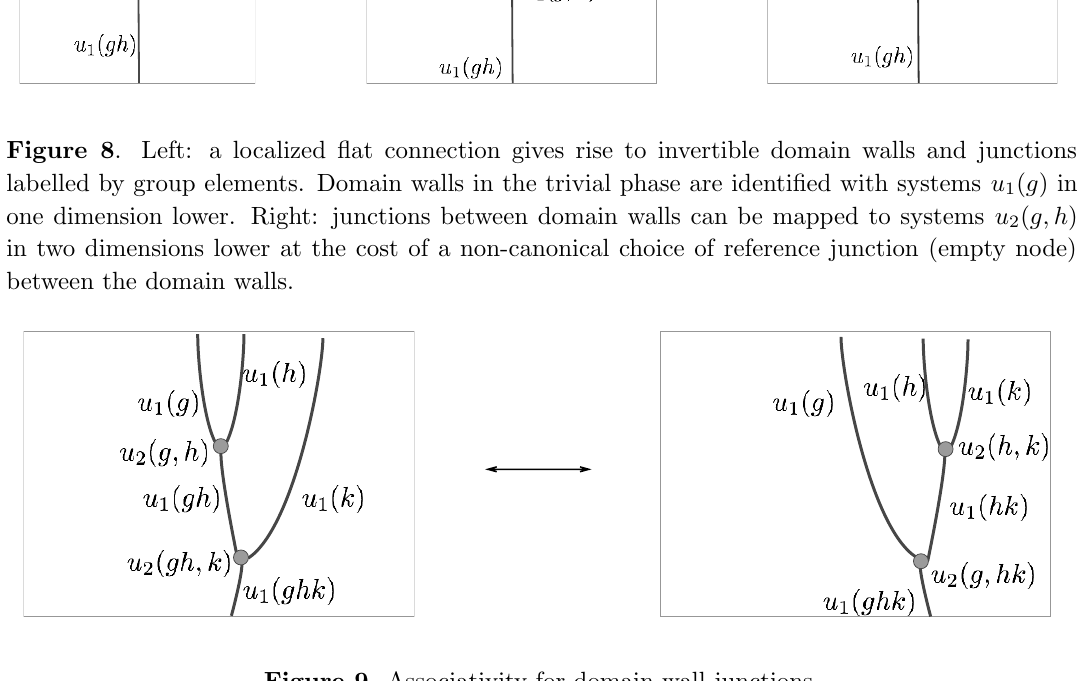
Figure 9 . Associativity for domain wall